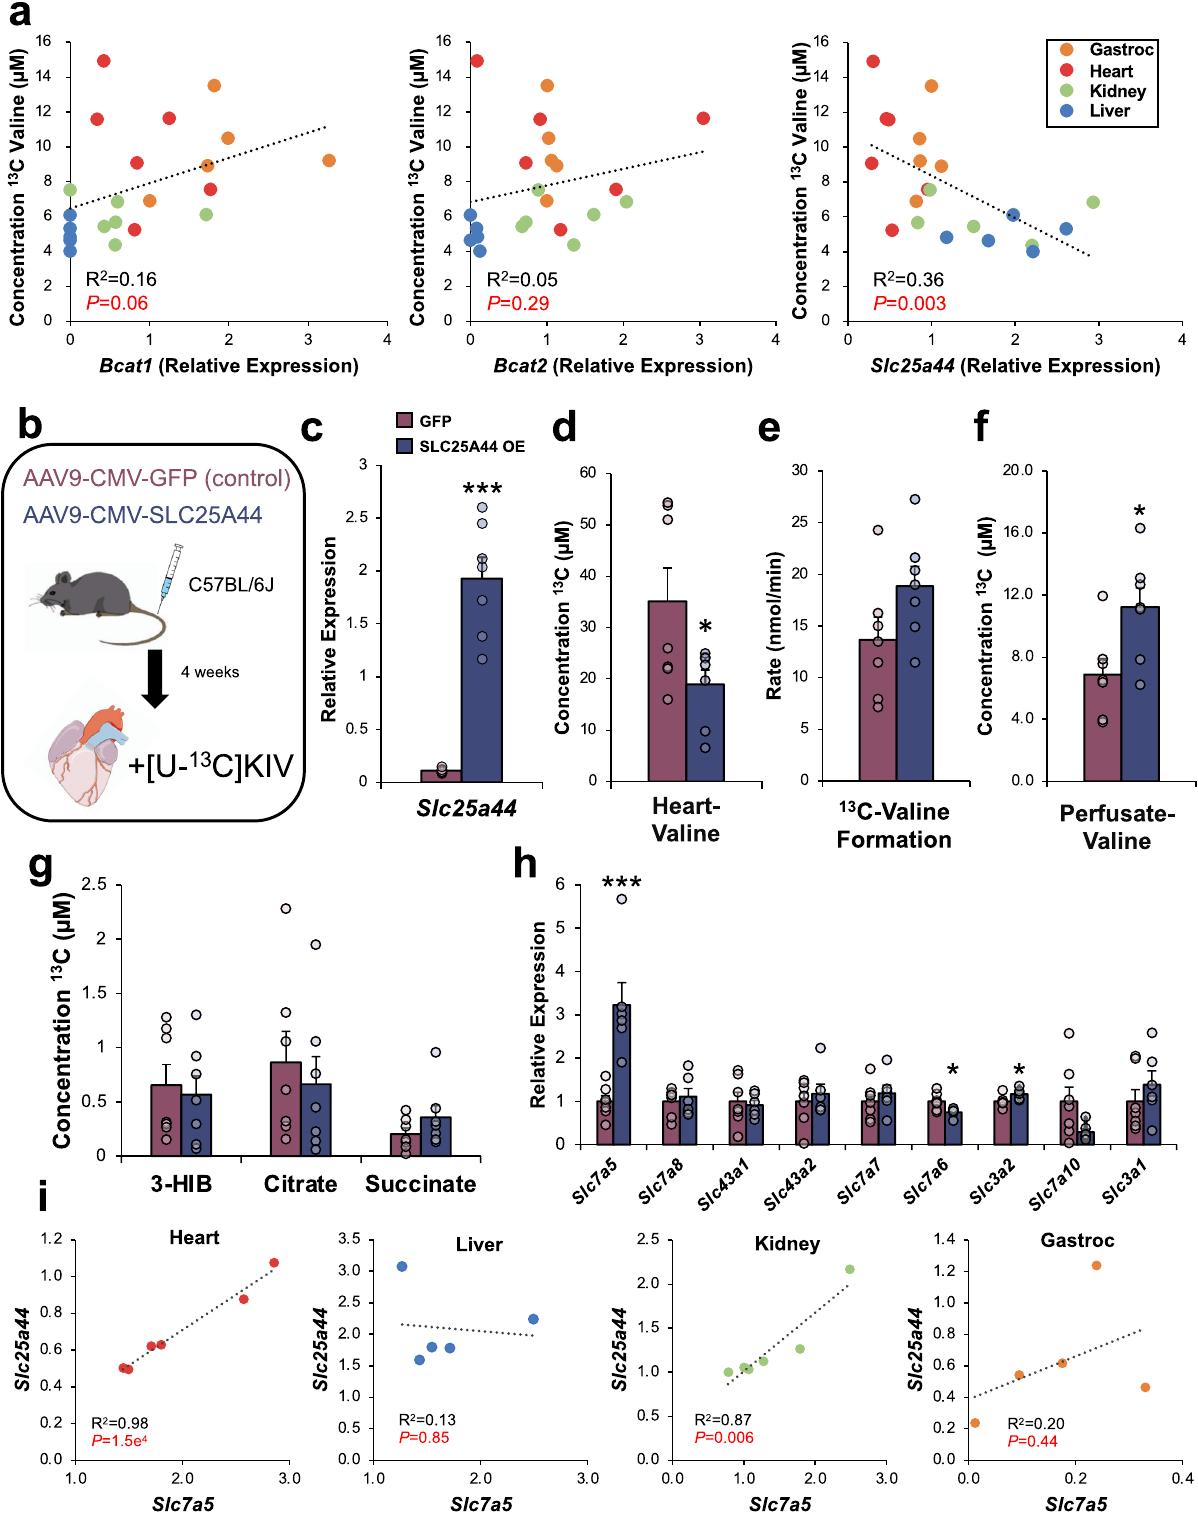
expression (Fig. 3a). In contrast, there was a strong inverse cor- relation between valine labeling and mitochondrial BCAA carrier Slc25a44 mRNA levels ( R 2 = 0.36, P < 0.003). This fi nding sug- gests that BCAA are preferentially retained in the cytosolic compartment in the heart, thus favoring the accumulation of products of BCKA